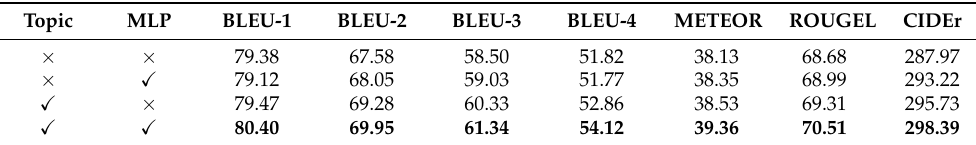
Table 4. Ablation experiment scores (%) on RSICD data set. Topic